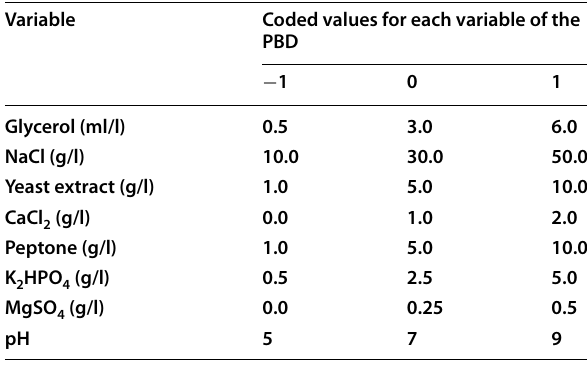
Table 1 The studied nutritional variables with their high and low values examined in PBD